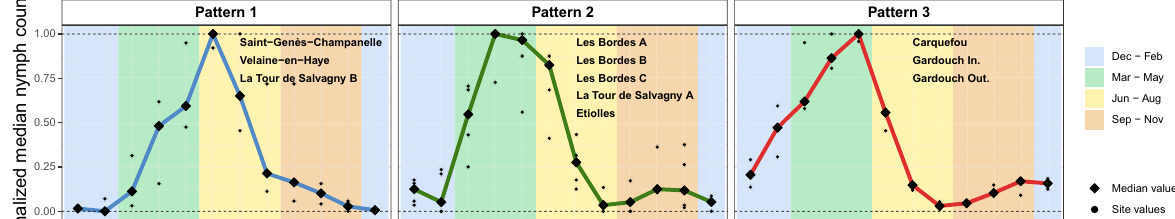
Jan Feb Mar Apr May Jun Jul Aug Sep Oct Nov Dec